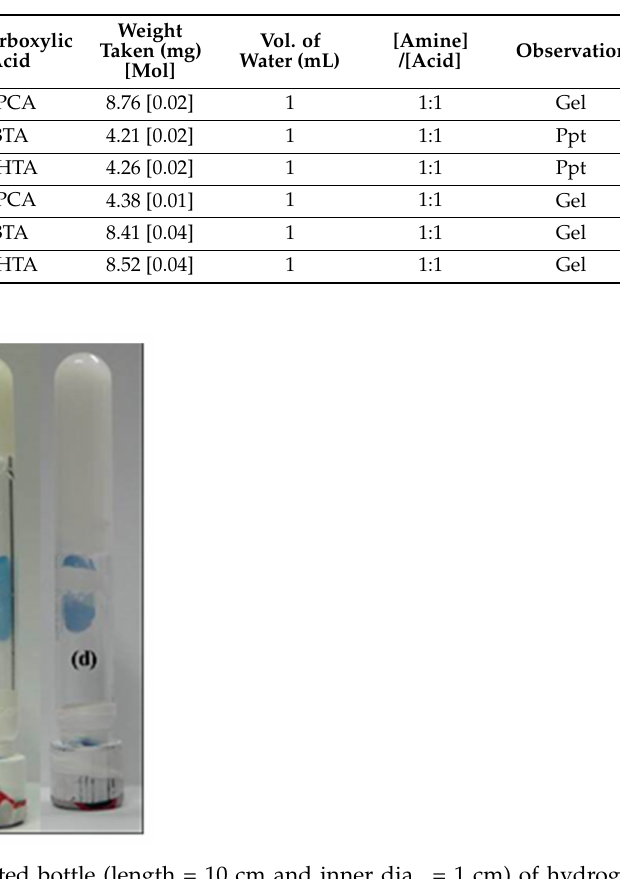
Table 1. Preparation of hydrogels having a molar ratio of 1:1 and observations.